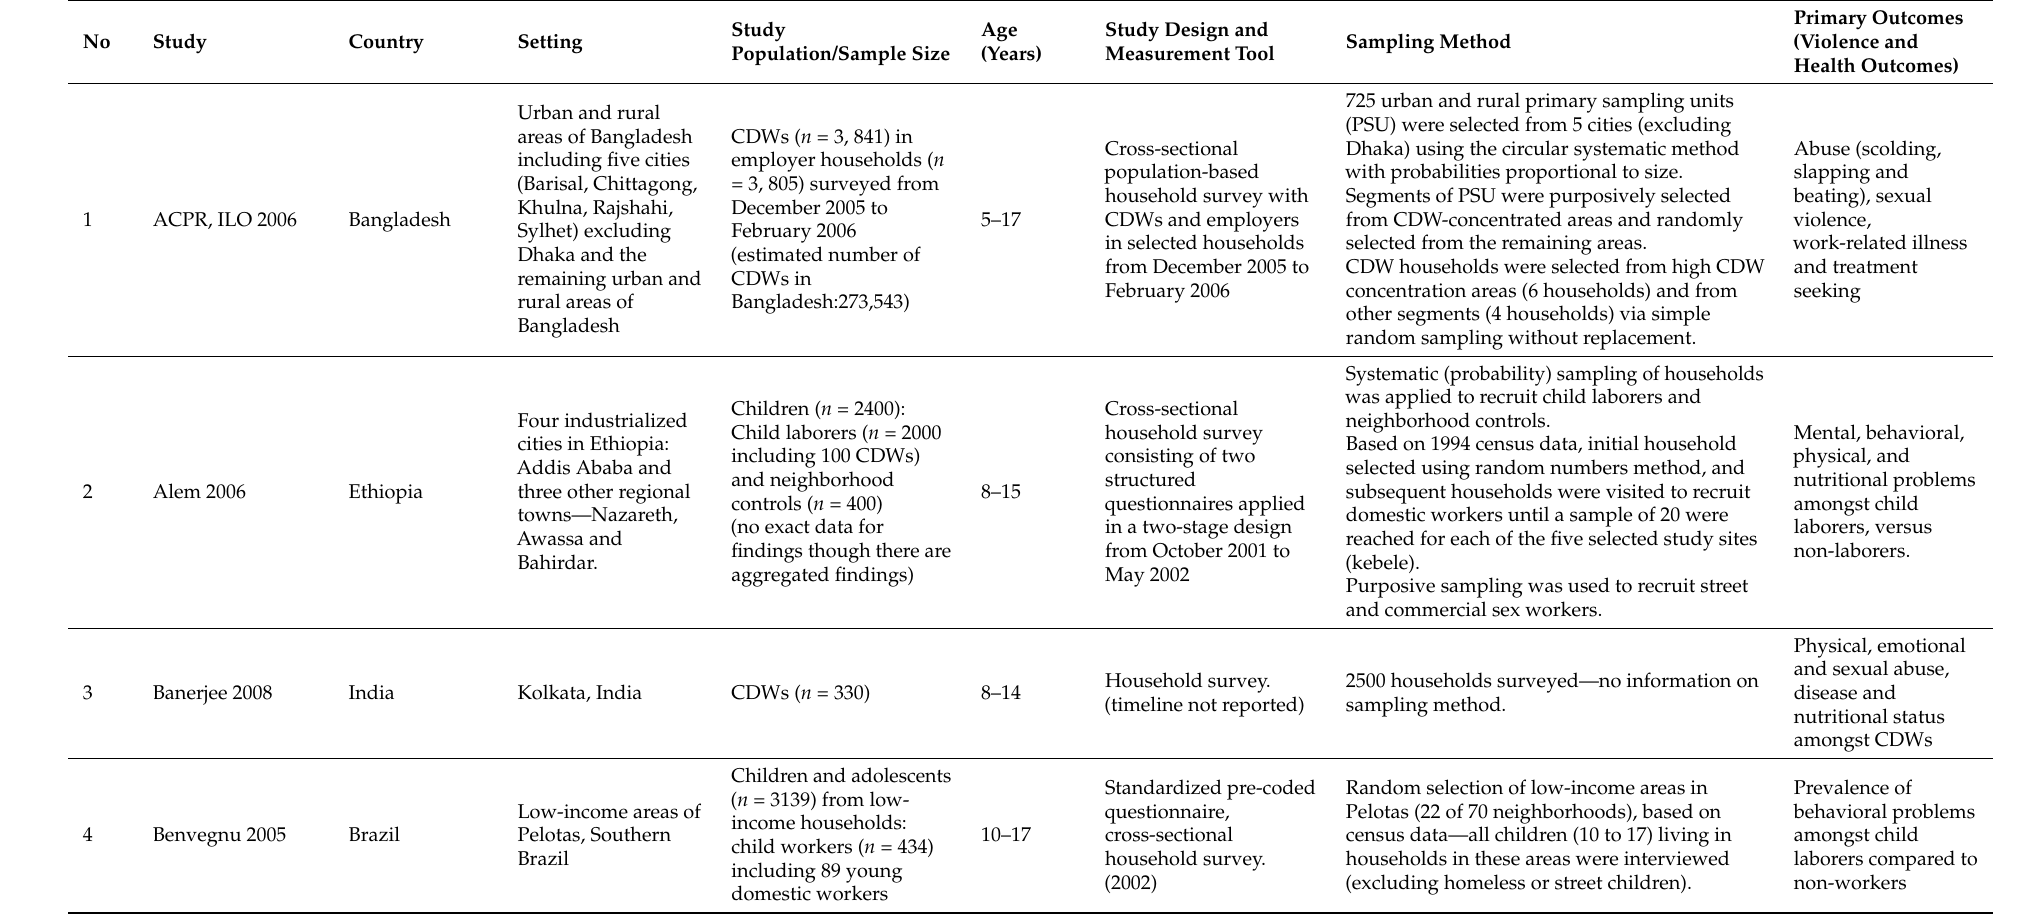
Table 1. Overview and characteristics of studies that reported violence and/or health outcomes among child domestic workers (CDW) ( n =